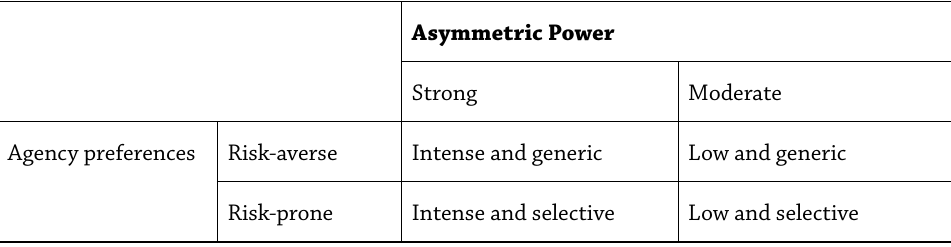
Table 2: Voluntary Accountability Outcomes